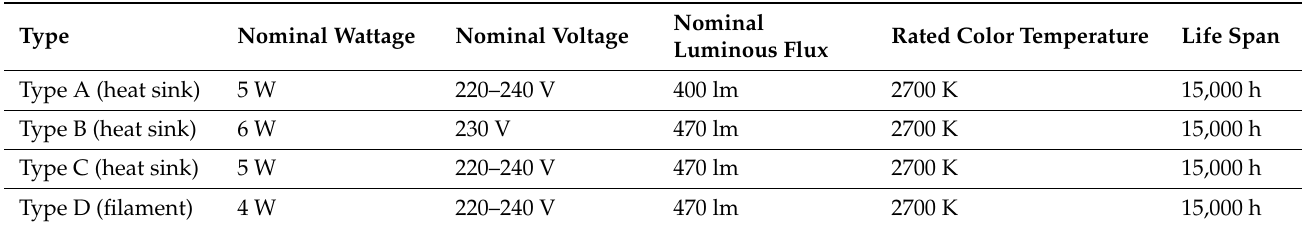
Table 1. Details of LED lamps